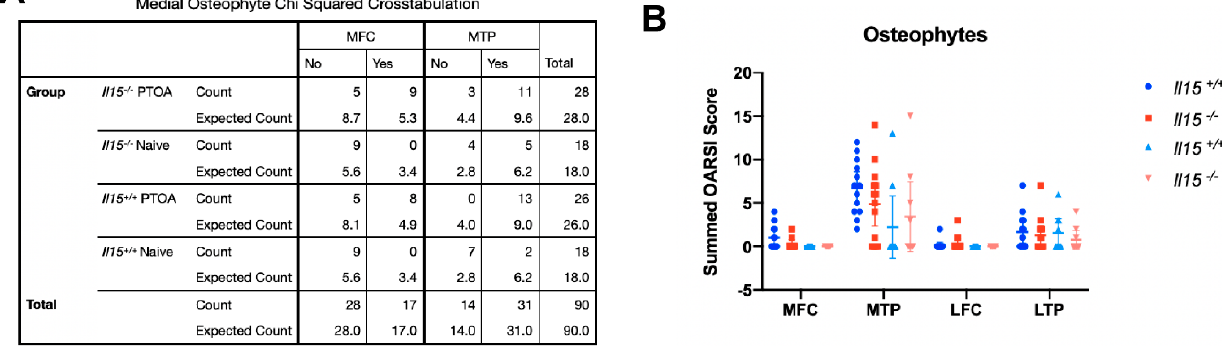
Figure 7. Osteophyte size is not significantly different between Il15 +/+ PTOA and Il15 − / − PTOA rats. Animals either underwent ACLT-DMM surgery to induce PTOA or served as control with no surgery (Naive). Osteophytes were analyzed for absence/presence and size in the 4 compartments: medial femoral condyle (MFC), medial tibial plateau (MTP), lateral femoral condyle (LFC), and lateral tibial plateau (LTP). ( A ) Presence of osteophytes was determined and agreed upon by two scorers. Chi-squared analysis with Cramer’s V established that the PTOA groups were strongly associated with osteophyte presence in the medial compartment, and moderately associated in the LFC, with no significance in the LTP. (MFC = X 2 (3, N = 45) = 18.24, p < 0.0001, Cramer’s V = 0.64, MTP = X 2 (3, N = 45) = 16.38, p < 0.005, Cramer’s V = 0.60, LFC = X 2 (6, N = 45) = 16.90, p < 0.05, Cramer’s V = 0.43, LTP = X 2 (3, N = 45) = 7.05, p > 0.05). ( B ) Two-way ANOVA with Tukey’s multiple comparison test was run, and data represents mean with 95% CI. There was no significant difference in the summed scores between the Il15 +/+ PTOA and Il15 − / − PTOA groups ( p > 0.05, N = 15 rats/PTOA group and 9 rats/Naive